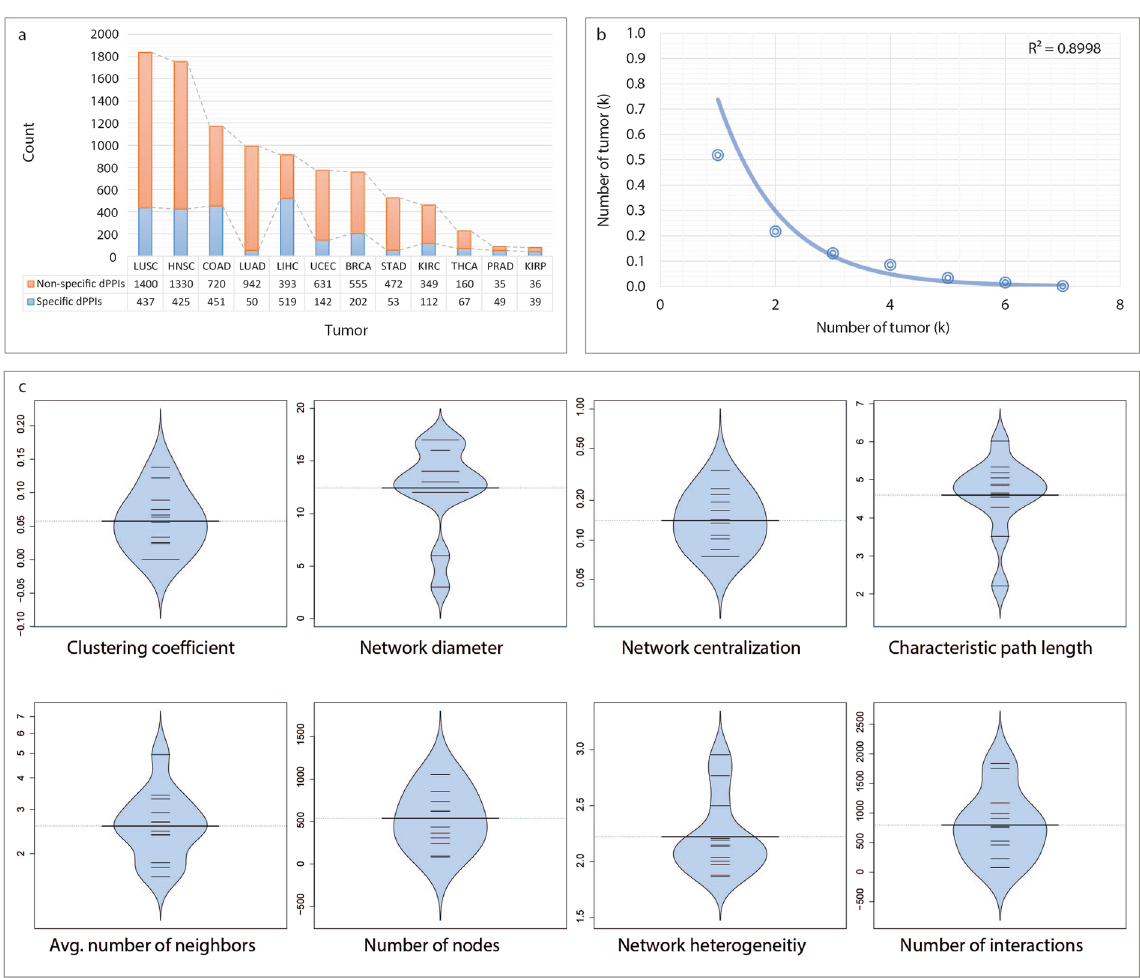
Figure 3. Differential interactome in human cancers. ( a ) Bar chart showing the numbers of interactions being specific and non-specific to the cancer types and their count ratio in the 12 different cancer types. ( b ) Graph indicates the prevalence of dPPIs in different cancers. ( c ) Topological characteristics of differential interactome networks. Bean plots represent the distribution of topological metrics (i.e., clustering coefficient, network diameter, network centralization, characteristic path length, average number of neighbors, network heterogeneity, number of nodes, and number of interactions) across constructed differential interactome networks. The individual observations are shown as small